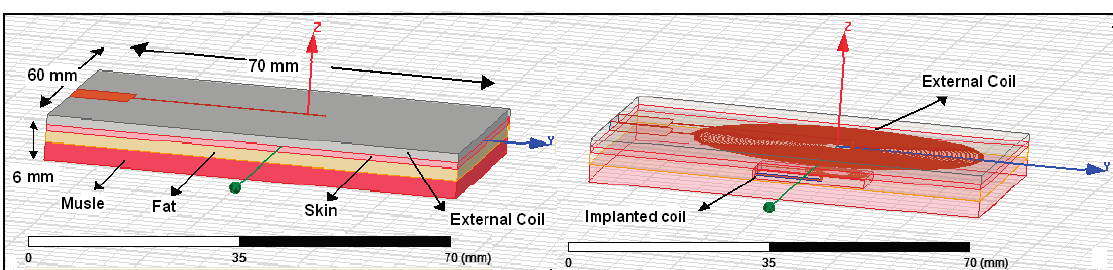
Figure 5. Pancake coils simulated with a proposed dimension of a human biological tissue